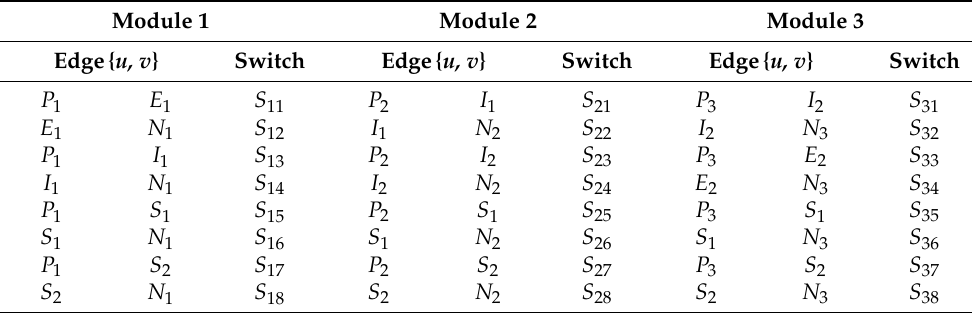
Figure 3. G graph of the 3-modules CHB-B2B in the ISOP array. Table 1. Edge list for G graph of the 3-modules CHB-B2B in ISOP array.